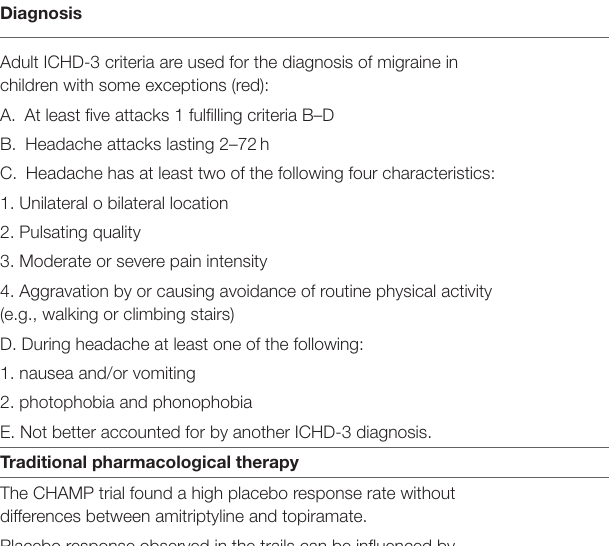
TABLE 2 | Summary of the main results of the study.